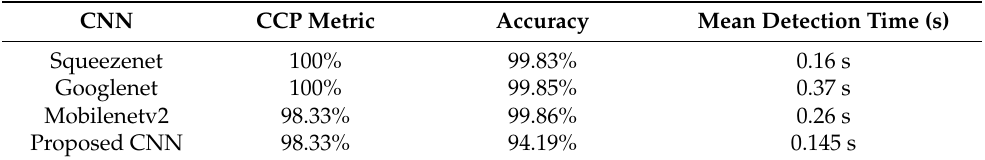
Table 7. Faster RCNN detector obtained results.